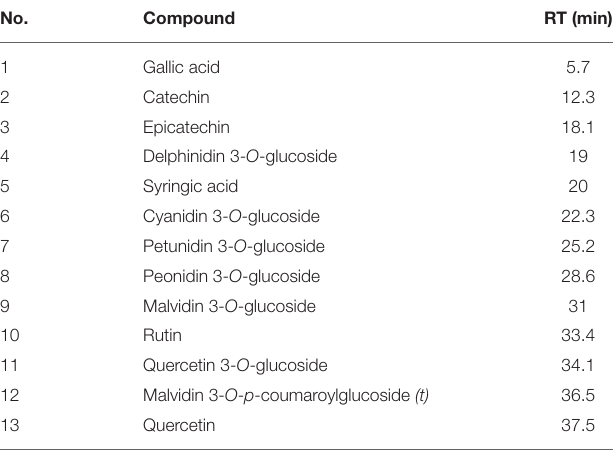
TABLE 2 | Peaks assignment of phenolic compounds extracted from grape pomace ( V. vinifera L., cv Nero di Troia).